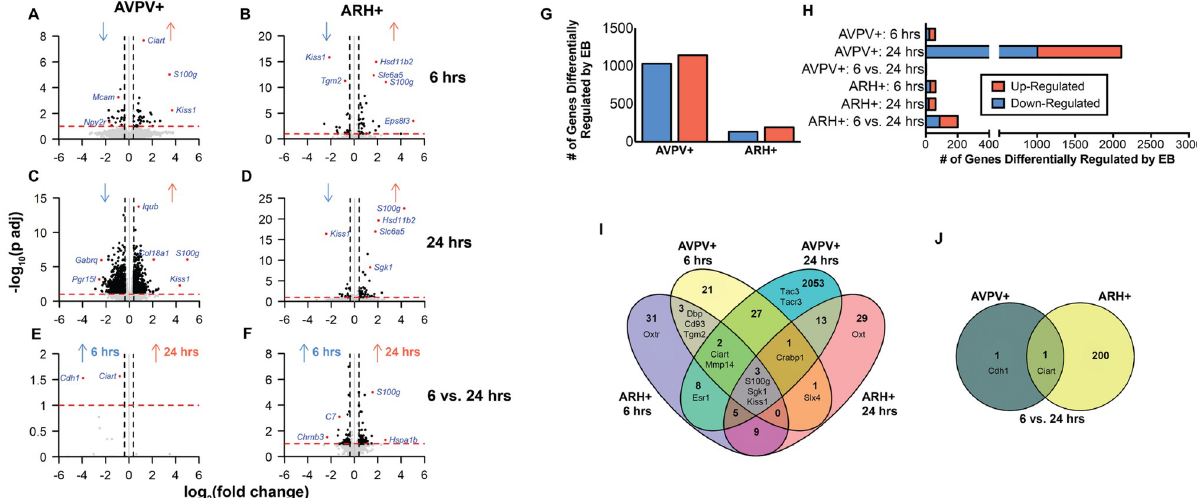
Fig 3. Differential gene expression analysis comparing the temporal responses to EB-induced transcription in the AVPV+ and ARH+, by comparing expression levels at baseline with 6 hrs post-EB and 24 hrs post-EB within each brain region. (A-F) Volcano Plots illustrating fold- change (log base 2) plotted against FDR-adjusted p value (- log base 10) of genes differentially expressed between EB treatment conditions. Note that in the baseline ARH vs. AVPV plot, -log10(adjusted p value) of Pmch was set to 145 so all points could be plotted within the 0–150 range. Horizontal bar at y = 1 represents a significance level of FDR < 0.1, p < 0.01, and vertical lines indicate fold change > |1.3| (grey dots did not reach our threshold of significance). (G) Overall (i.e., regardless of time post-EB), EB causes greater up-regulation of genes in the AVPV+ and the ARH+ (chi square df = 7.614, 1; z = 2.759, p < 0.0058). EB causes higher differential expression of genes in the AVPV+ compared with the ARH+. (H) In the AVPV+ the highest number of genes differentially expressed by EB is observed 24 hours post-EB. In the ARH, the highest number of genes differentially expressed by EB occurs between 6 and 24 hours post-EB. (I) Venn diagram depicting the overlap of genes differentially expressed by estradiol relative to baseline 6 hrs post-EB, 24 hrs post-EB in both the AVPV+ and ARH+. (J) Venn diagram depicting the overlap of genes differentially expressed between 6 and 24 hrs post-EB in both the AVPV+ and